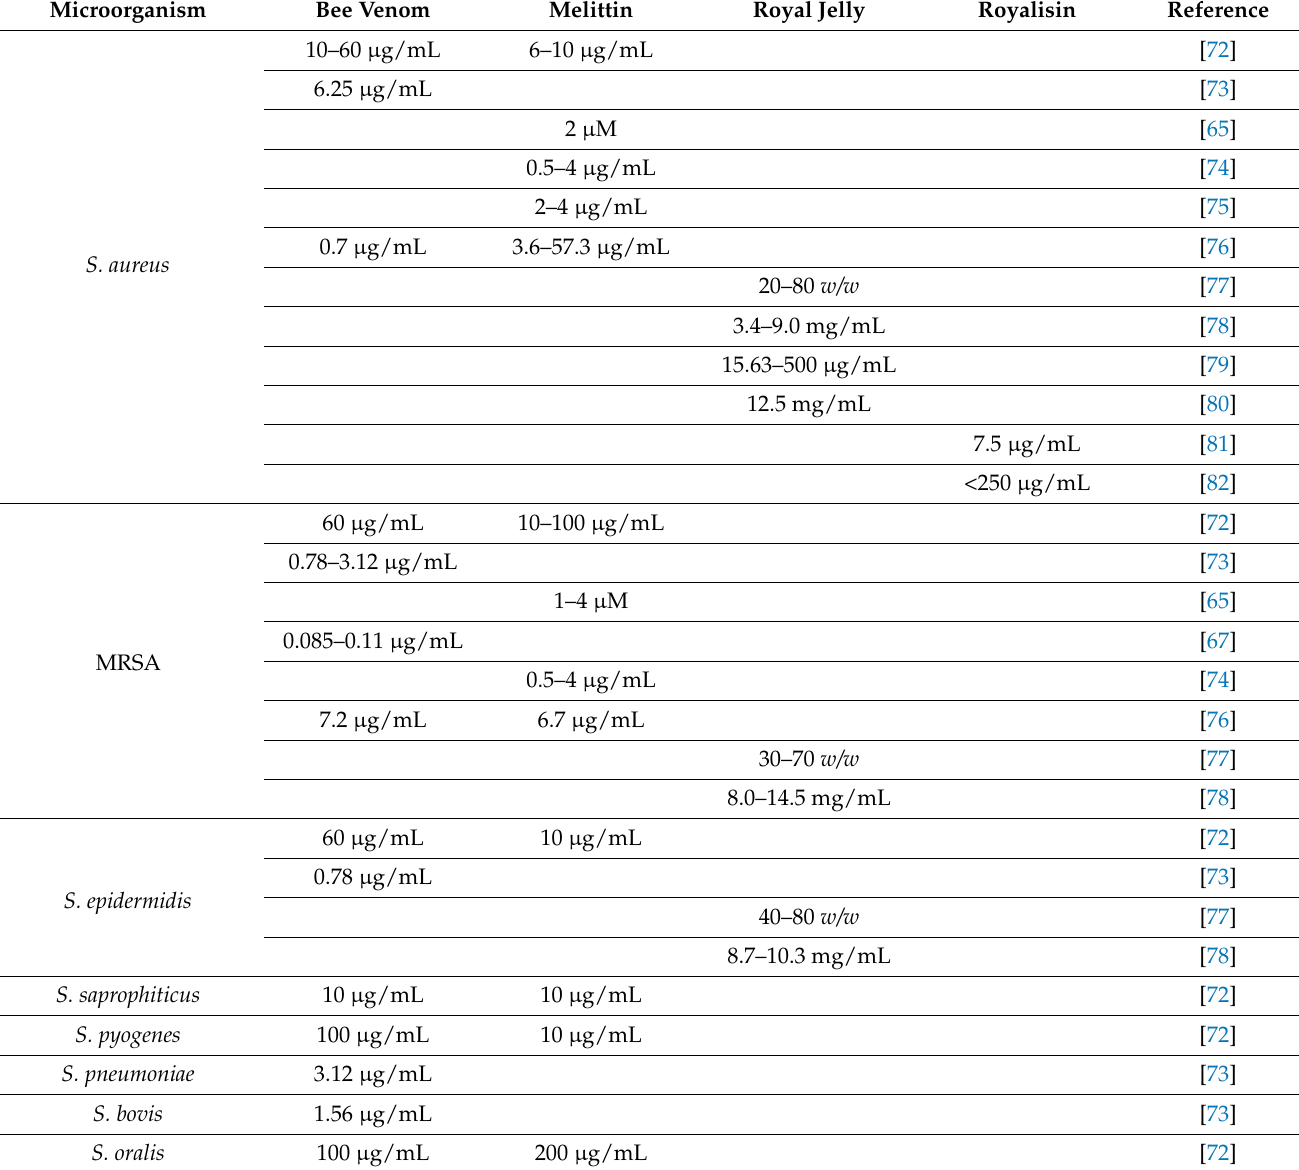
Table 3. The activity of bee venom, melittin and royal jelly against microorganisms. Microorganism Bee Venom Melittin Royal Jelly Royalisin